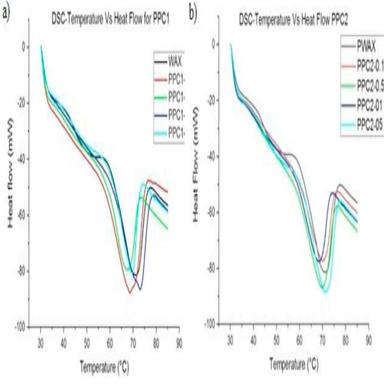
DSC results for a) PPC1; b) PPC2.